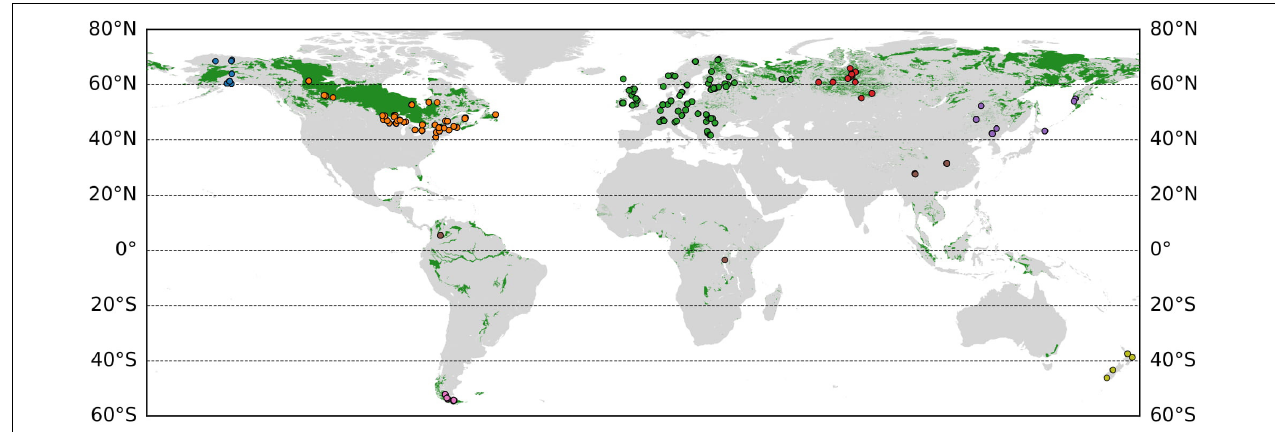
FIGURE 1 | Global map of peatland regions (green areas; Yu et al., 2010) and sites with Sphagnum δ 18 O c data presented in this study. Sites are color-coded to represent different regions: Alaska (blue), Canada and Contiguous US (orange), Europe (green), New Zealand (yellow), Patagonia (pink), Temperate East Asia (purple), Tropics and Subtropics (brown), and West Siberia